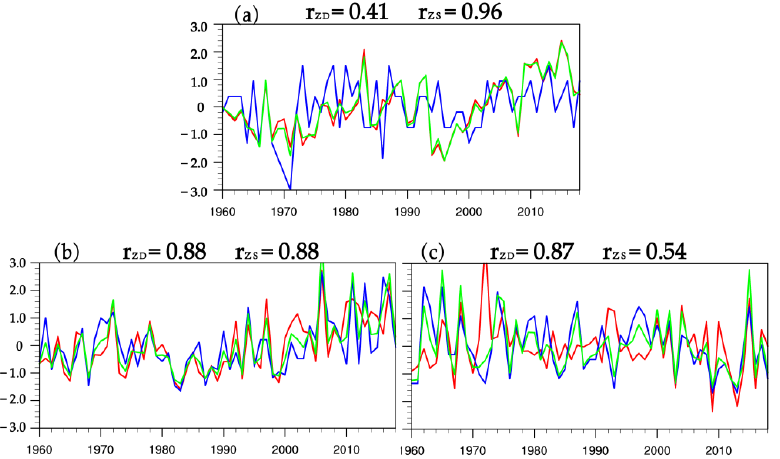
Figure 4. Red line: intensity; blue line: days; green line: accumulated temperature. r ZD : correlation coefficient between accumulated temperature and days, r ZS : correlation coefficient between accumulated temperature and intensity. Interannual variation graph: ( a ) 28 °C, ( b ) 32 °C, ( c ) 36 °C.